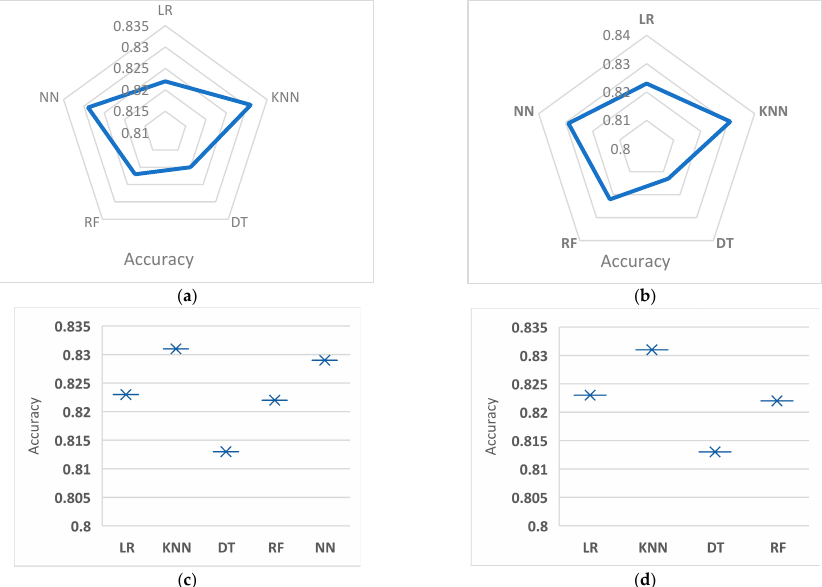
Figure 3. Accuracy under different combinations. ( a ) Feature selection (No), Augmentation (No). ( b ) Feature selection, (No) Augmentation (Yes). ( c ) Feature selection (No), Augmentation (Yes). ( d ) Feature selection (Yes), Augmentation (Yes). Table 4. Performance of different machine learning models.